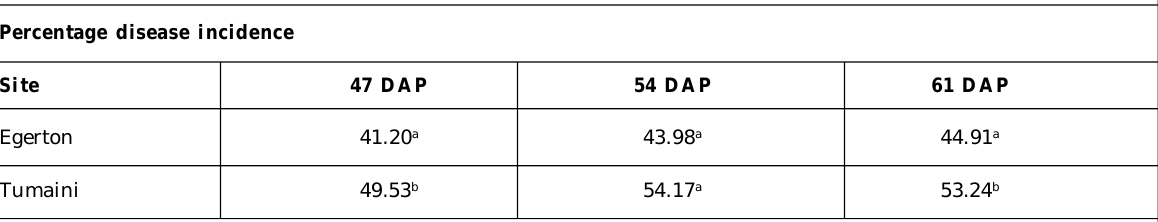
Table 2: Effects of experimental sites on P. infestans incidence on potatoes crop Percentage disease incidence